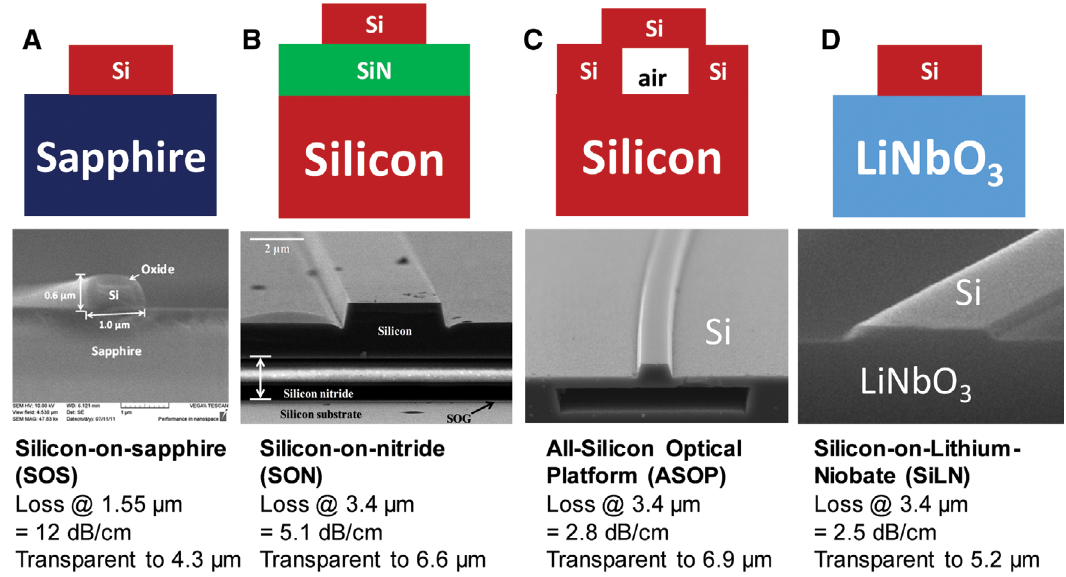
top silicon layer adjacent to the rib waveguides [207]. However, due to the via forming and isotropic wet etching steps, the attained membranes become too wide to be mechanically and thermally stable, i.e., they are prone to vibrations, bowing and low thermal dissipation. The processing steps for the approach developed at CREOL, shown in Figure 12, address these shortcomings. An inverted SOI wafer is fusion-bonded to a bulk silicon substrate pre-patterned with trenches. Similar to the dis- cussed SON processing steps, the SOI substrate and BOX trench is exposed. The air-filled trench acts as the